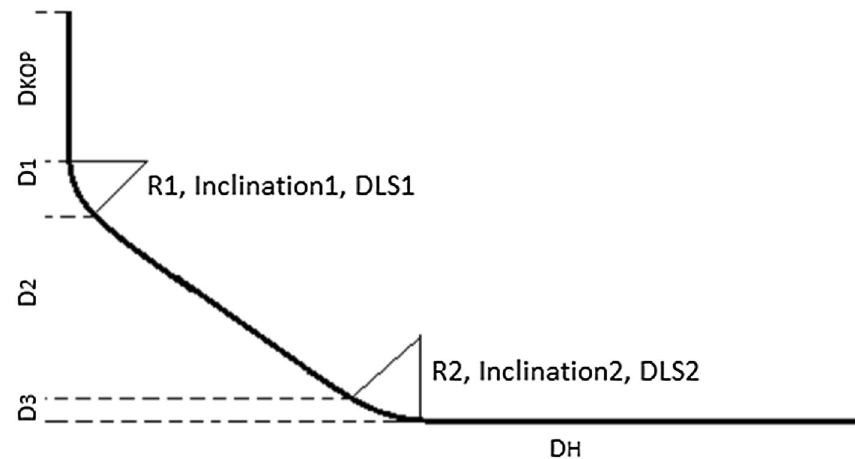
Fig. 2 The vertical plane of a horizontal well (first case study) with the operational parameters.